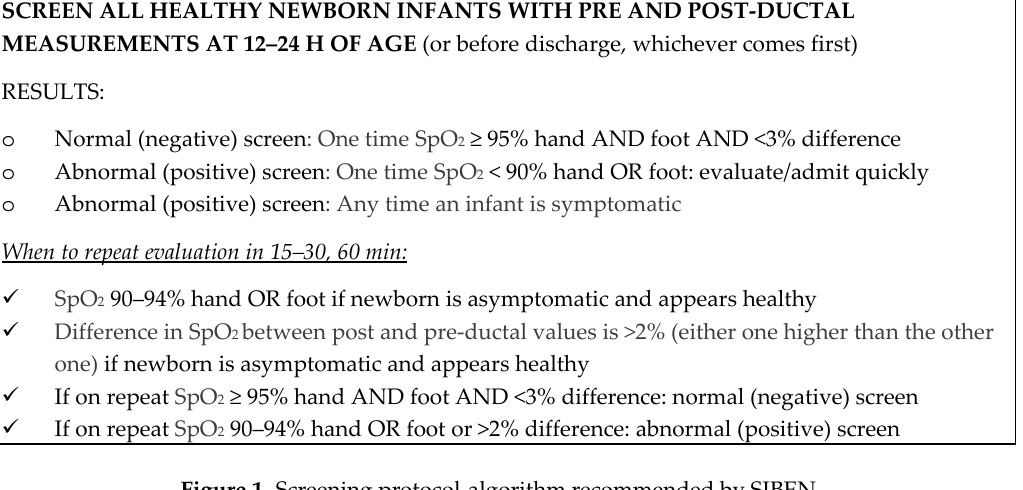
Figure 1. Screening protocol-algorithm recommended by SIBEN.